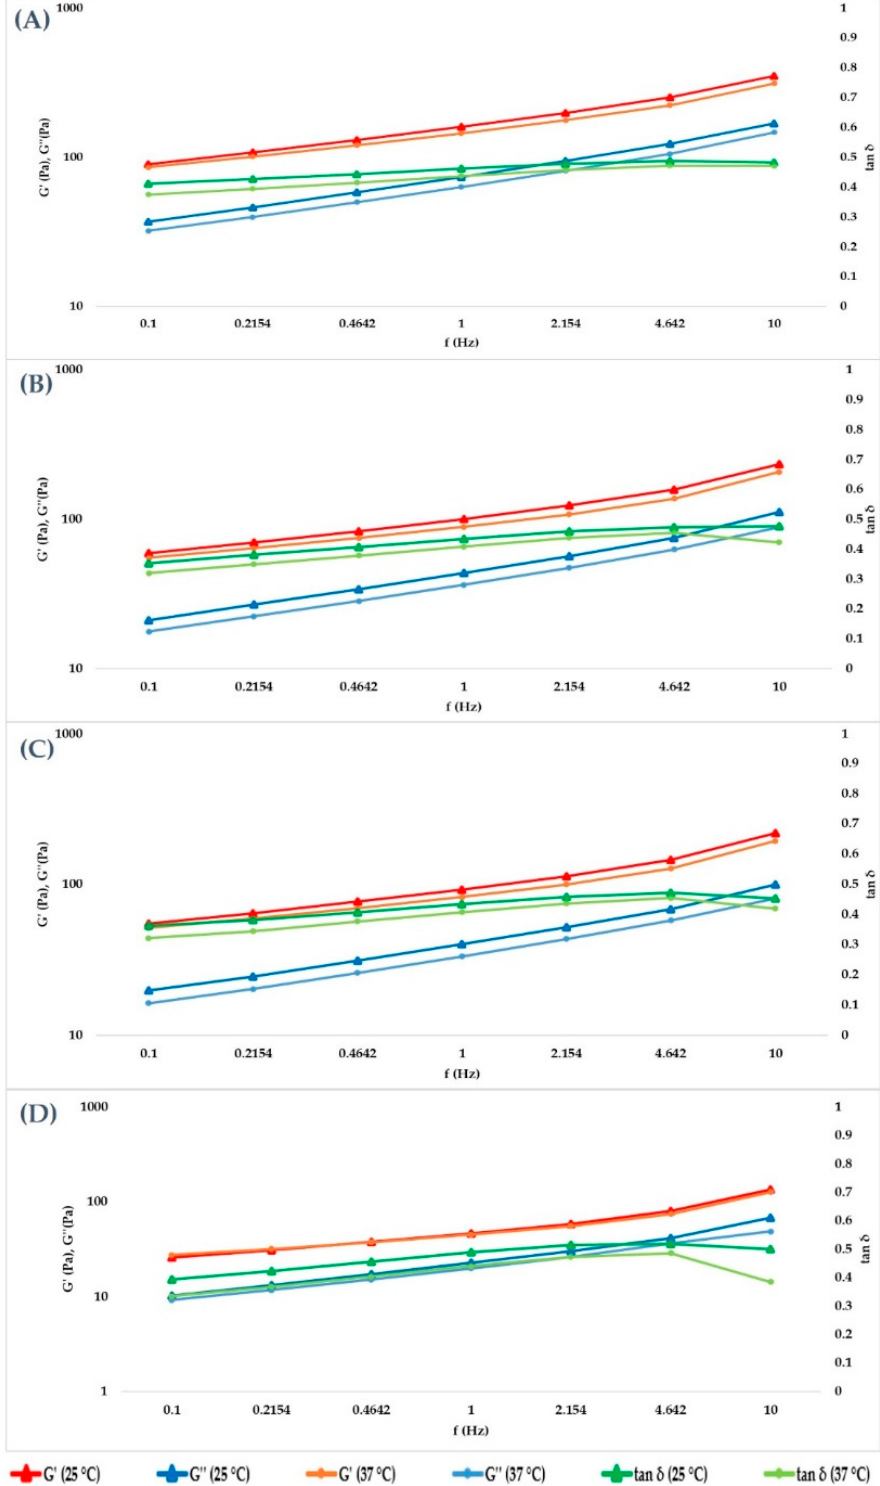
Figure 7. Cross-linked HA hydrogels G’, G” and tan δ . ( A – D ) are graphical representations of the cross-linked HA 28, 26, 24 and 22 mg/mL trends, at increasing frequency.